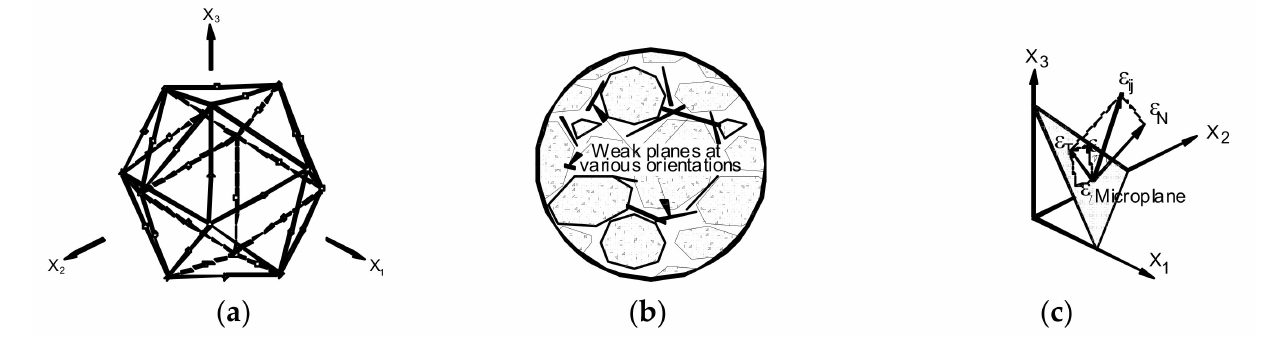
Figure 7. Representative material element in microplane model: ( a ) spatial distribution of microplanes, ( b ) weak planes at level, ( c ) decomposition of strain microstructure tensor on a microplane